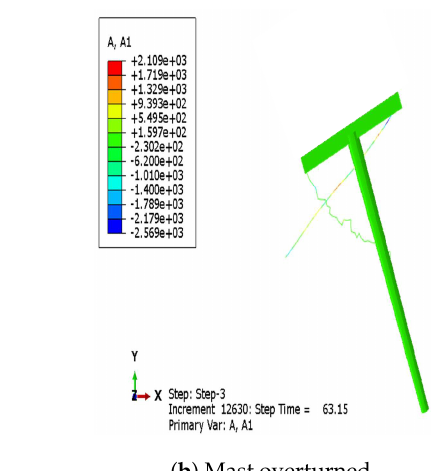
( a ) Overturning of mast started. ( b ) Mast overturned. Figure 19. Overturning failure of mast under vertical ground motion.